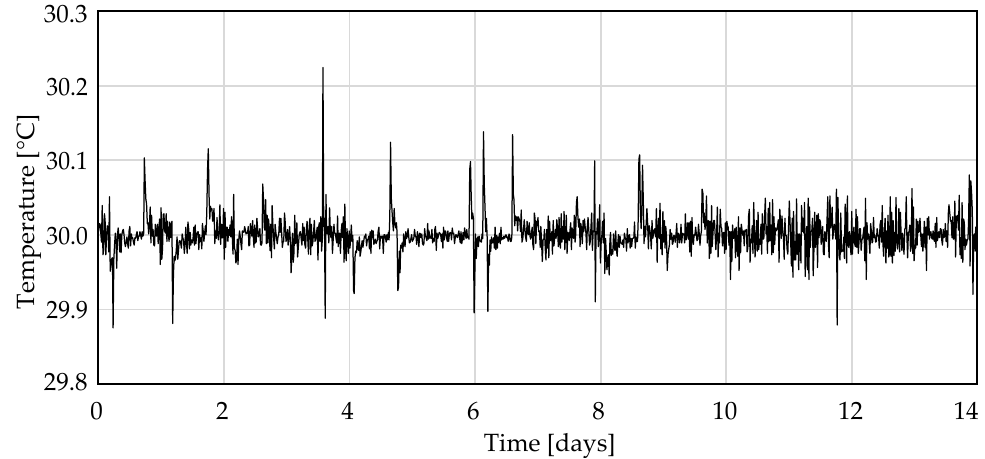
Figure 6. Temperature of the reference impedance for two weeks.